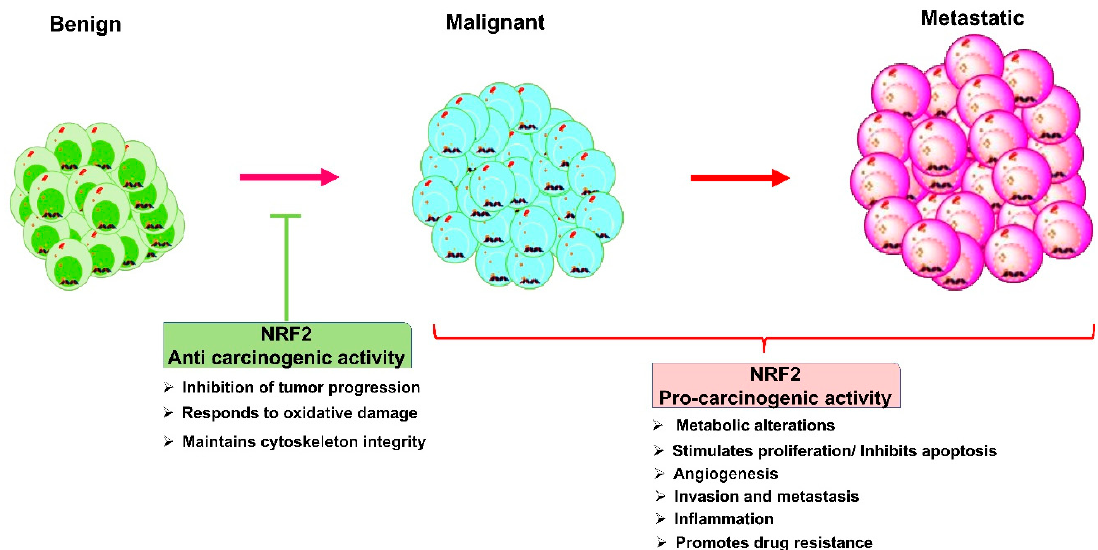
Figure 4. The dual role of Nrf2 in cancers: Nrf2 is a double ‐ edged sword, which confers both anticarcinogenic activity and pro ‐ carcinogenic functions. Nrf2 acts as a tumor ‐ suppressive protein by blocking the transformation of benign cancer cells into malignant cancer cells and maintaining cytoskeleton integrity and impairing tumor progression. As an oncogenic protein, Nrf2 suppresses apoptotic cell death mechanisms, switches the metabolisms of cancer cells to anaerobic glycolysis and HMP shunts, and enhances angiogenesis. As a result, Nrf2 fosters cell proliferation invasion, metastasis, and drug resistance.